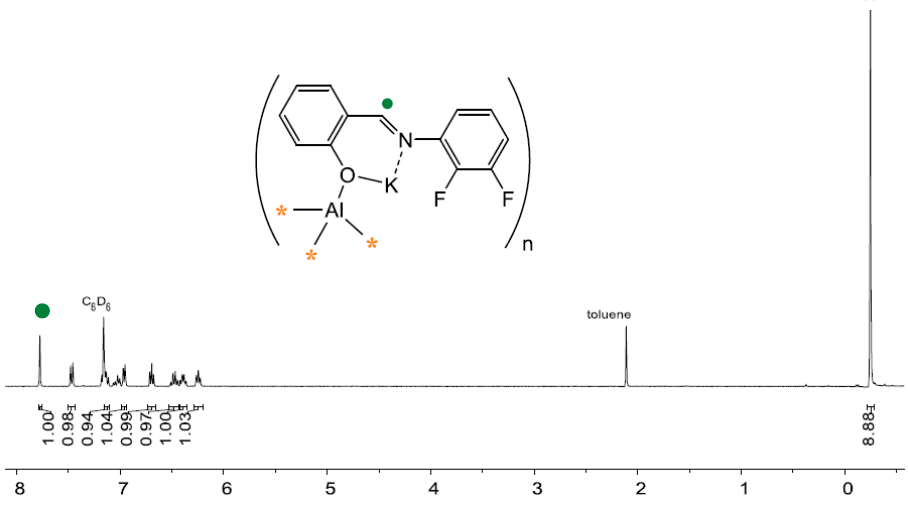
Figure 3. 1 H NMR spectrum of complex 1 recorded in C 6 D 6 at room temperature.